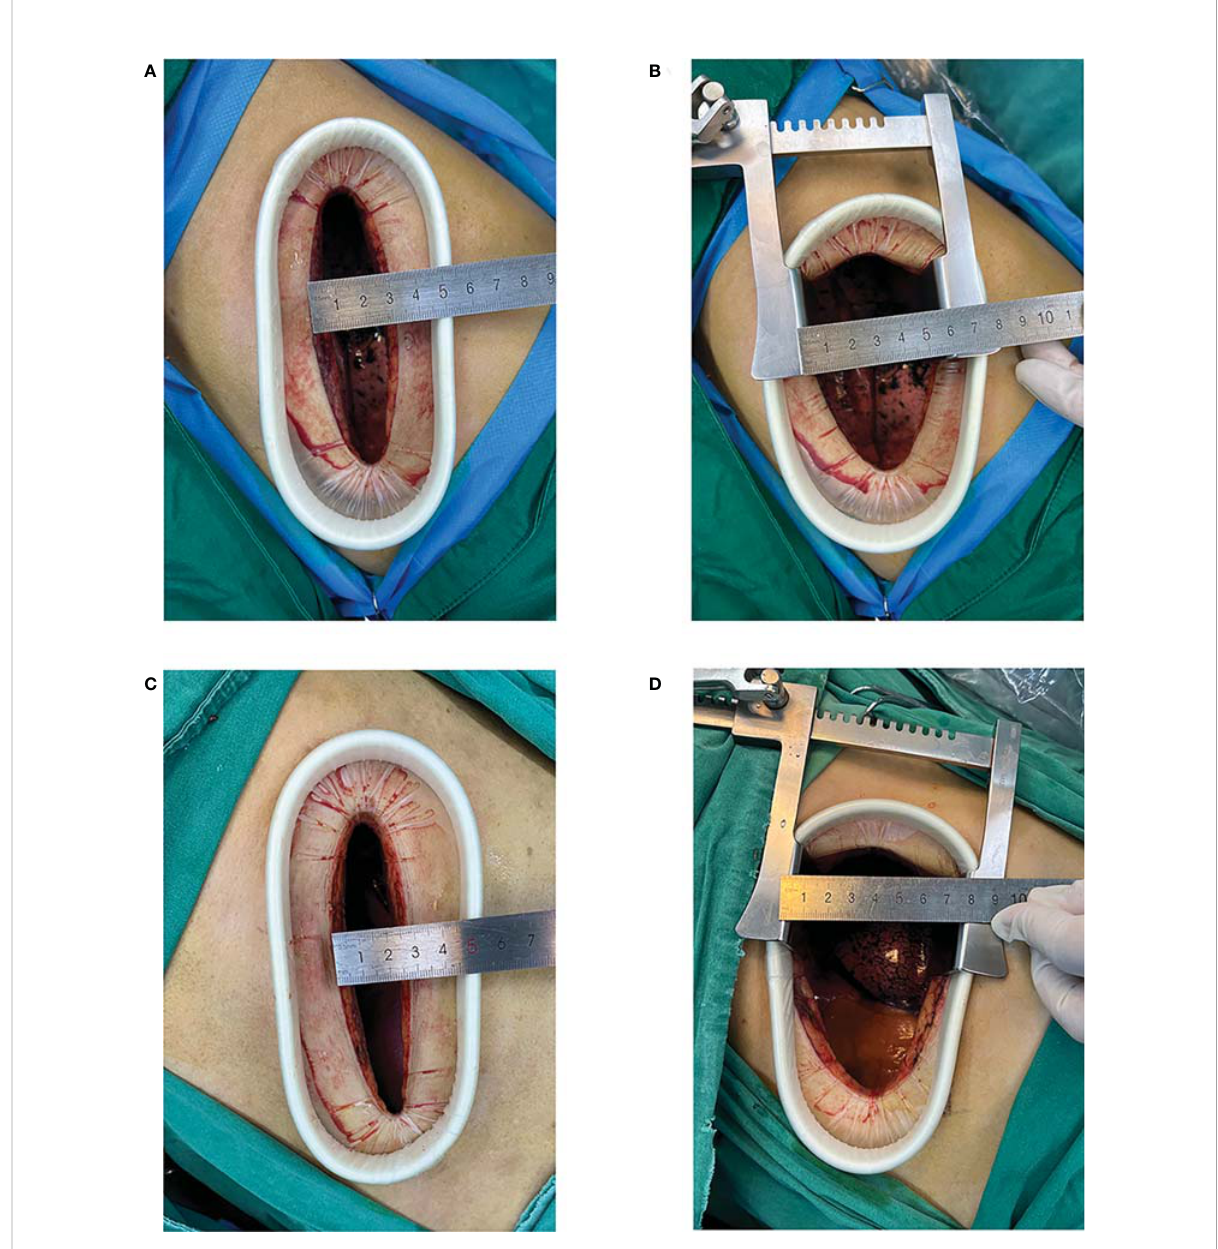
FIGURE 1 Video-assisted mini-thoracotomy (VAMT) surgical incision. (Top row) Group A: original intercostal incision (A) ; intercostal distance measured after using the metal rib spreader (B) (Bottom row) Group B: original intercostal incision (C) ; intercostal distance measured after using the metal rib spreader (D)